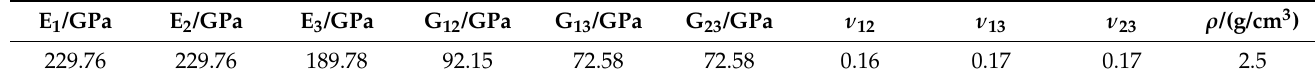
Figure 7. Geometric dimensions (mm) of 2D SiC/SiC stiffened plate. Table 4. Material parameters of 2D SiC/SiC stiffened plate.